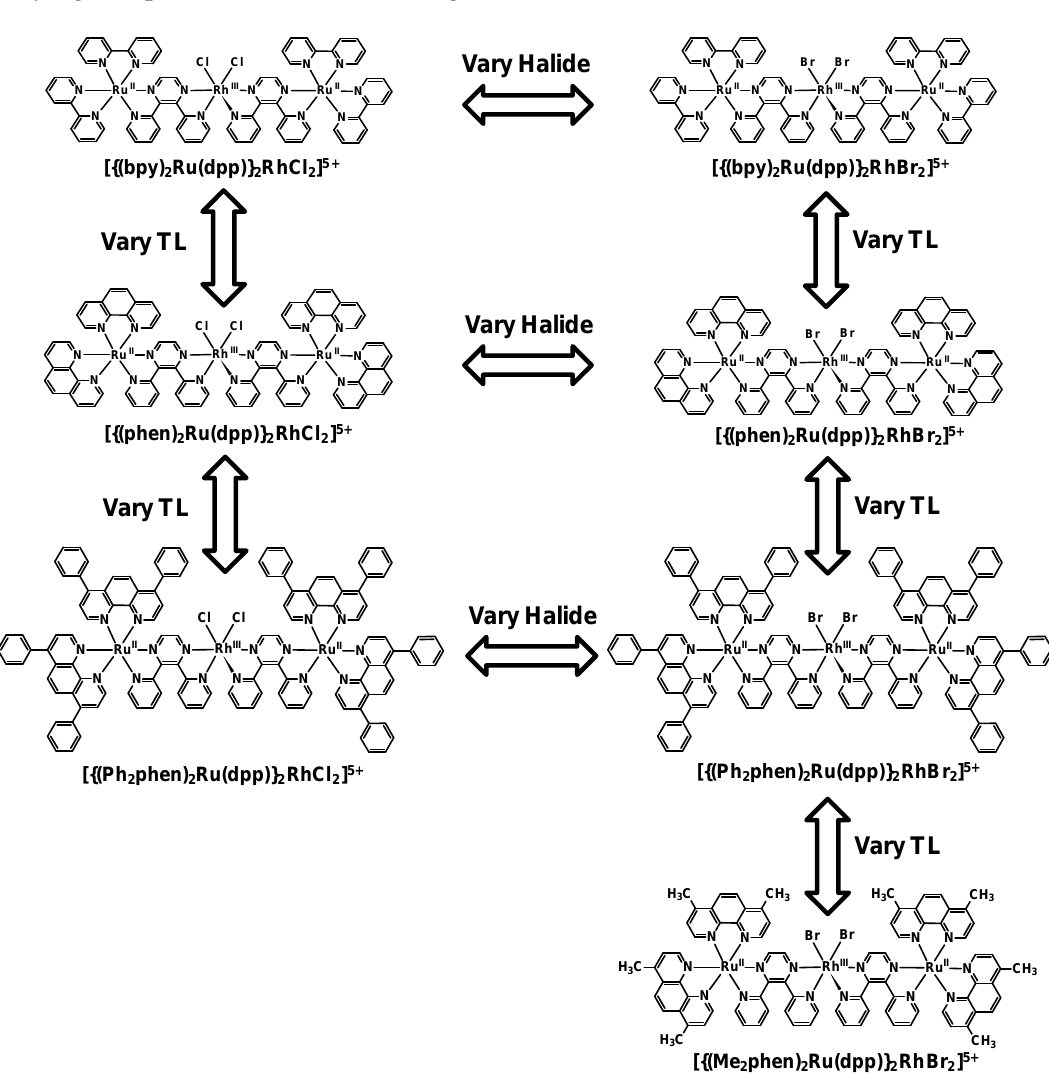
Figure 12. Polyazine-bridged Ru(II),Rh(III),Ru(II) supramolecular complexes with varying components. TL = terminal ligand.